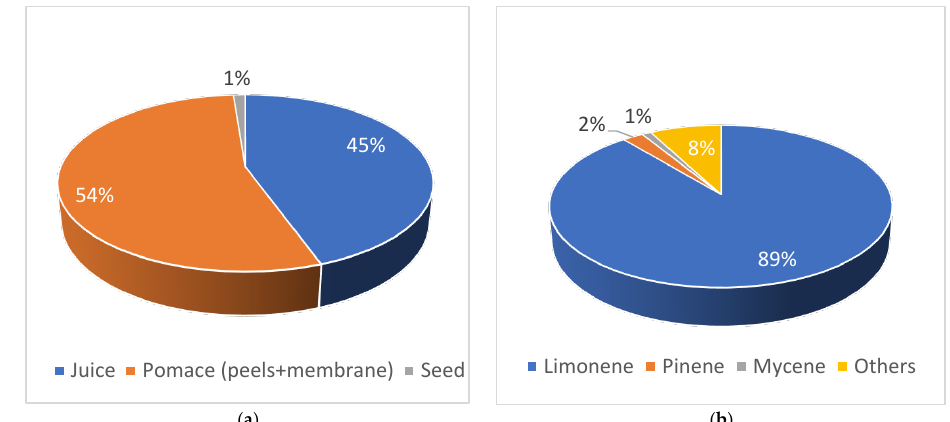
Figure 2. Composition of oranges ( a ) and its bioactive compounds ( b ).